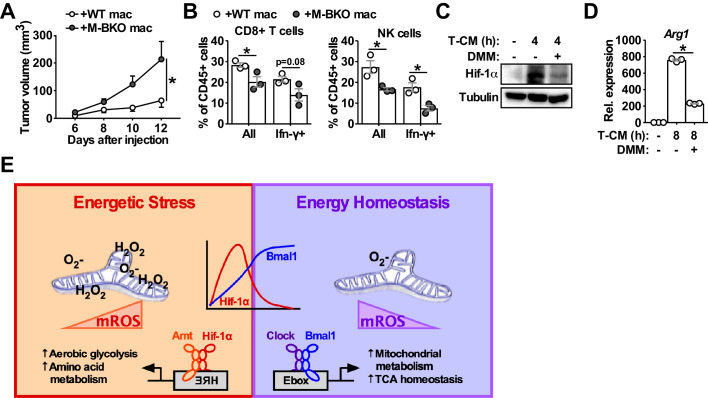
Macrophage Bmal1 regulates tumor growth in a cell-autonomous manner.(A) Tumor volume in M-BKO male mice co-injected with 500,000 B16-F10 cells and either 500,000 WT or M-BKO macrophages as indicated. N = 6 mice, statistical analysis was performed using two-way ANOVA to compare WT vs M-BKO macrophage co-injection across the time course. (B) Flow cytometric analyses of tumor-infiltrating CD8+ T cells (CD45+CD3+CD8a+ cells, left panel) and NK cells (CD45+CD3–NK1.1+ cells, right panel) stimulated ex vivo with phorbol 12-myristate 13-acetate and ionomycin for Ifn-γ co-staining. Tumors that are represented in panel (A) were pooled into three groups prior to isolation of infiltrating leukocytes for flow cytometric analyses. Statistical analysis was performed using Student’s T test. Data are presented as mean ± S.E.M. *, p<0.05. (C) Hif-1α protein levels in WT macrophages treated with (from left to right) control medium or B16-F10 tumor-conditioned medium (T–CM) diluted 1:1 with control medium without or with co-treatment with 10 mM dimethyl malonate (DMM) for 4 hr. (D) Arg1 gene expression in WT macrophages treated as in panel (C) for 8 hr. N = 3 biological replicates. Statistical analysis was performed using Student’s T test. Experiments were repeated at least twice. (E) Schematic showing the working model for Bmal1–Hif-1α crosstalk in the regulation of macrophage bioenergetics and effector functions. Both M1 and tumor-associated macrophages share similar energetically stressed states. Bmal1 preserves mitochondrial oxidative metabolism while reducing oxidative stress to modulate Hif-1α activity and support proper effector functions. Deletion of Bmal1 in the macrophage leads to reliance on glycolytic metabolism and alternative fuel utilization, notably amino-acid metabolism, which further promotes mROS production and Hif-1α protein stabilization. Increased amino-acid utilization by M-BKO macrophages may lead to depletion of amino acids that are critical for lymphocyte activation and cytotoxic function, thereby suppressing anti-tumor immunity in the tumor microenvironment.